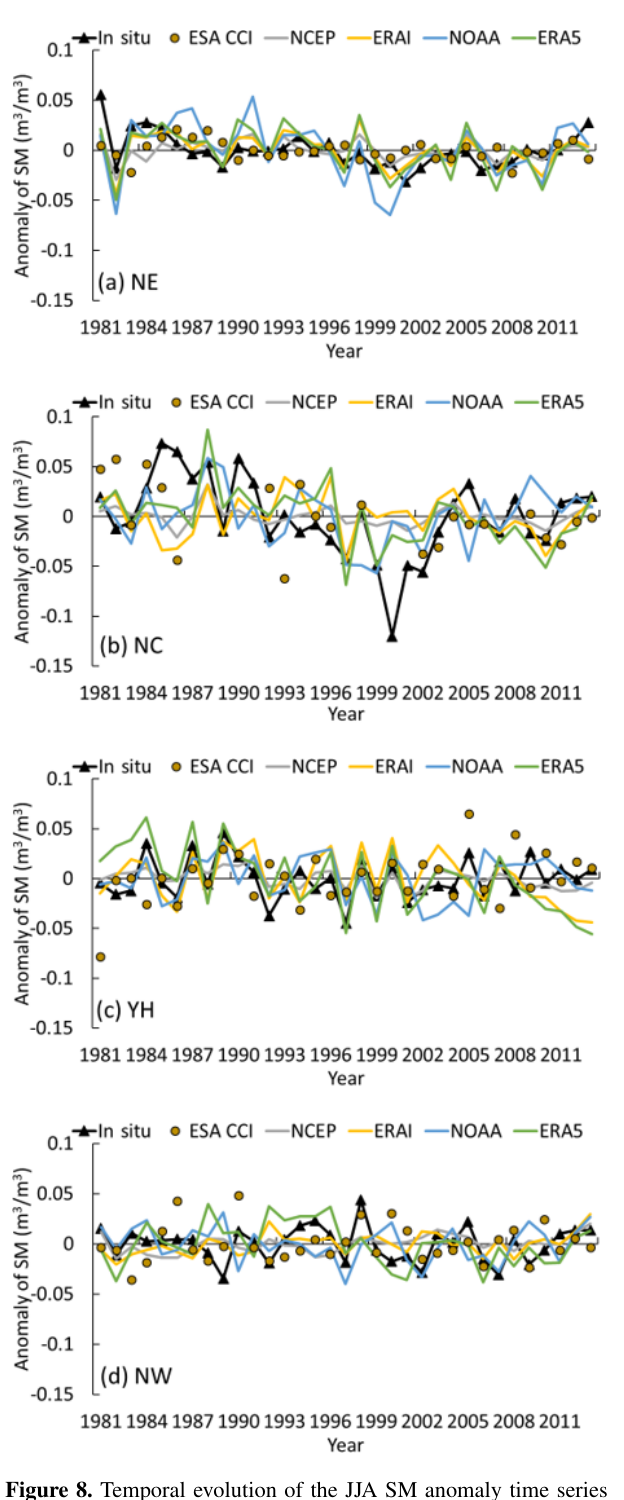
Figure 8. Temporal evolution of the JJA SM anomaly time series from observations and the five satellite and reanalysis products in four research regions from 1981 to 2013.